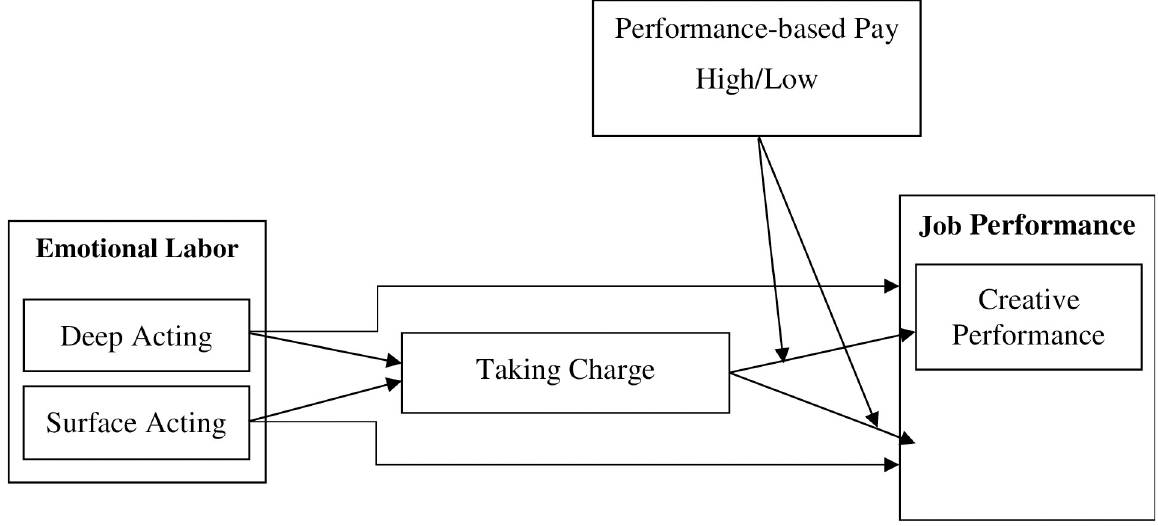
Fig 1. The hypothesized